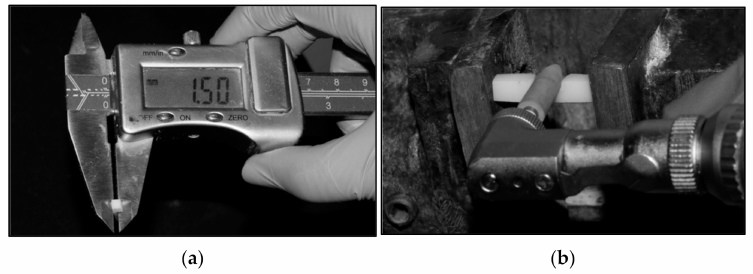
Figure 3. ( a ) The specimens had dimensions of 15 mm length × 3 mm width × 3 mm